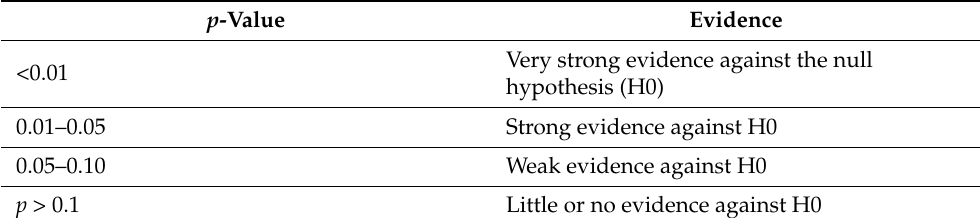
Table 15. P -values.